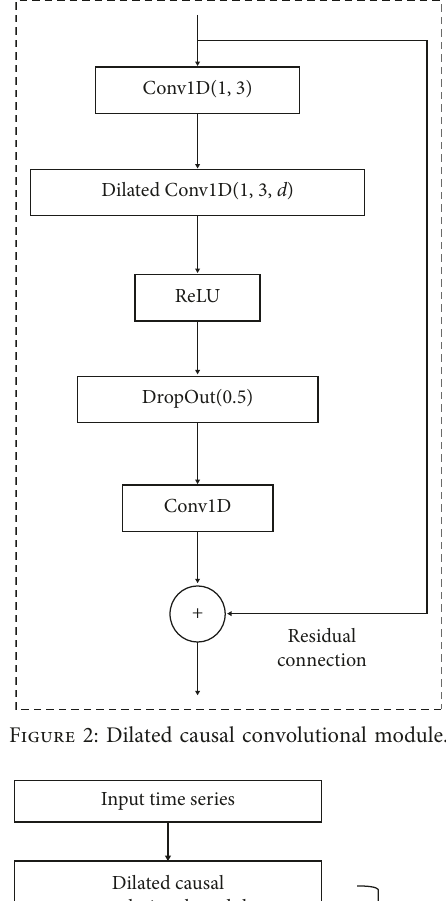
Figure 2: Dilated causal convolutional module.